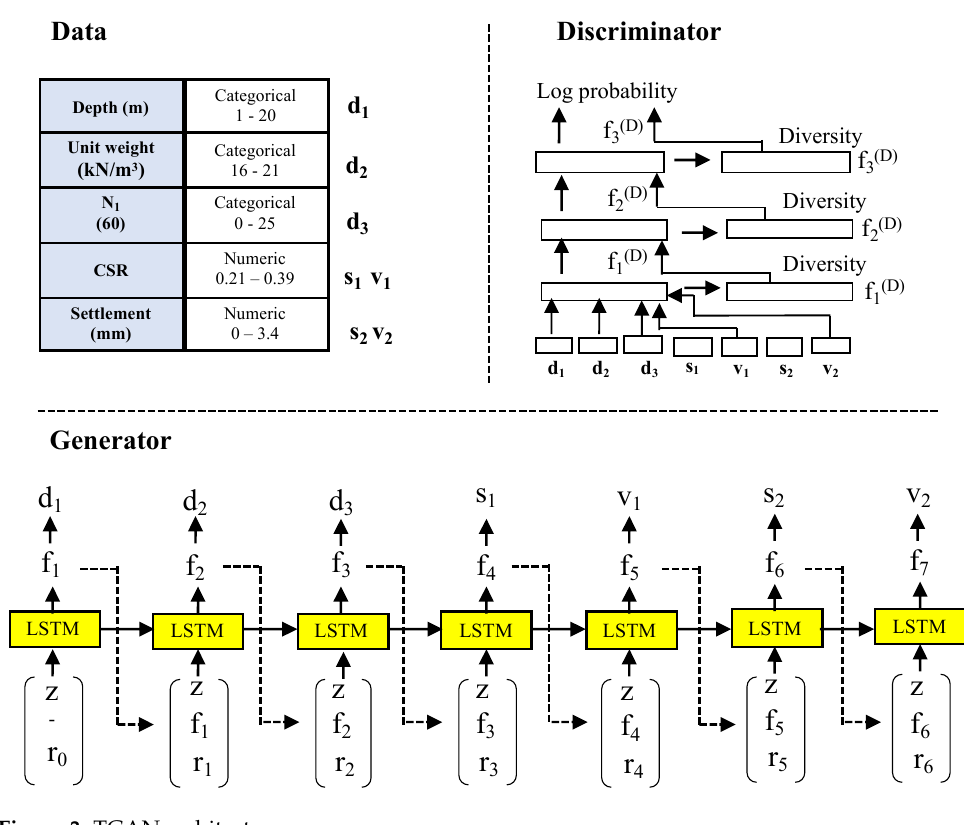
Figure 3. TGAN architecture.